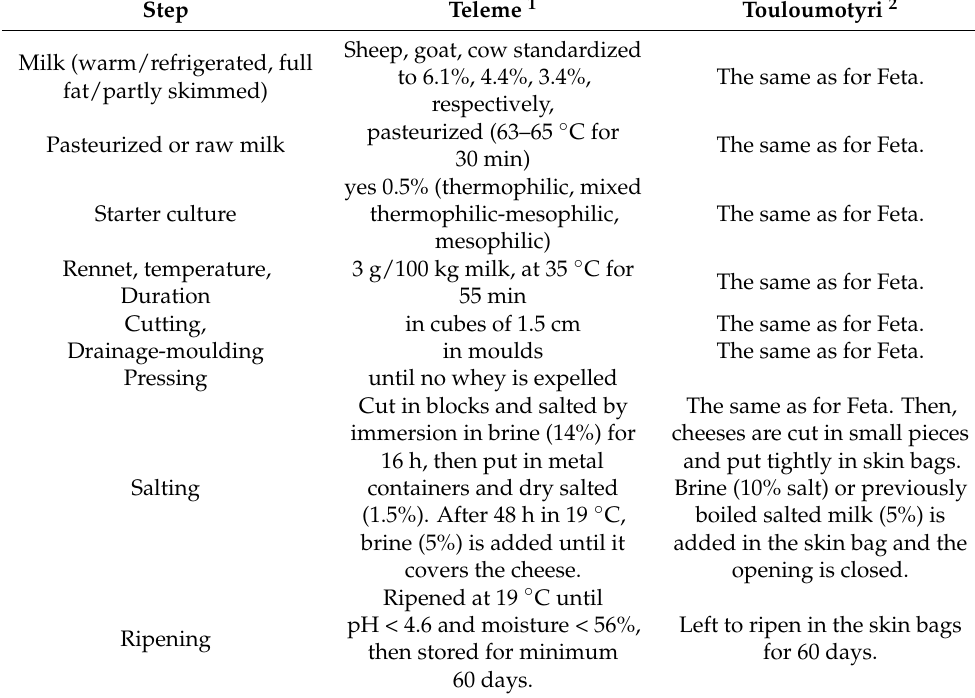
Table 7. Manufacturing technology of nonprotected designation of origin and nonprotected geo- graphical indication soft